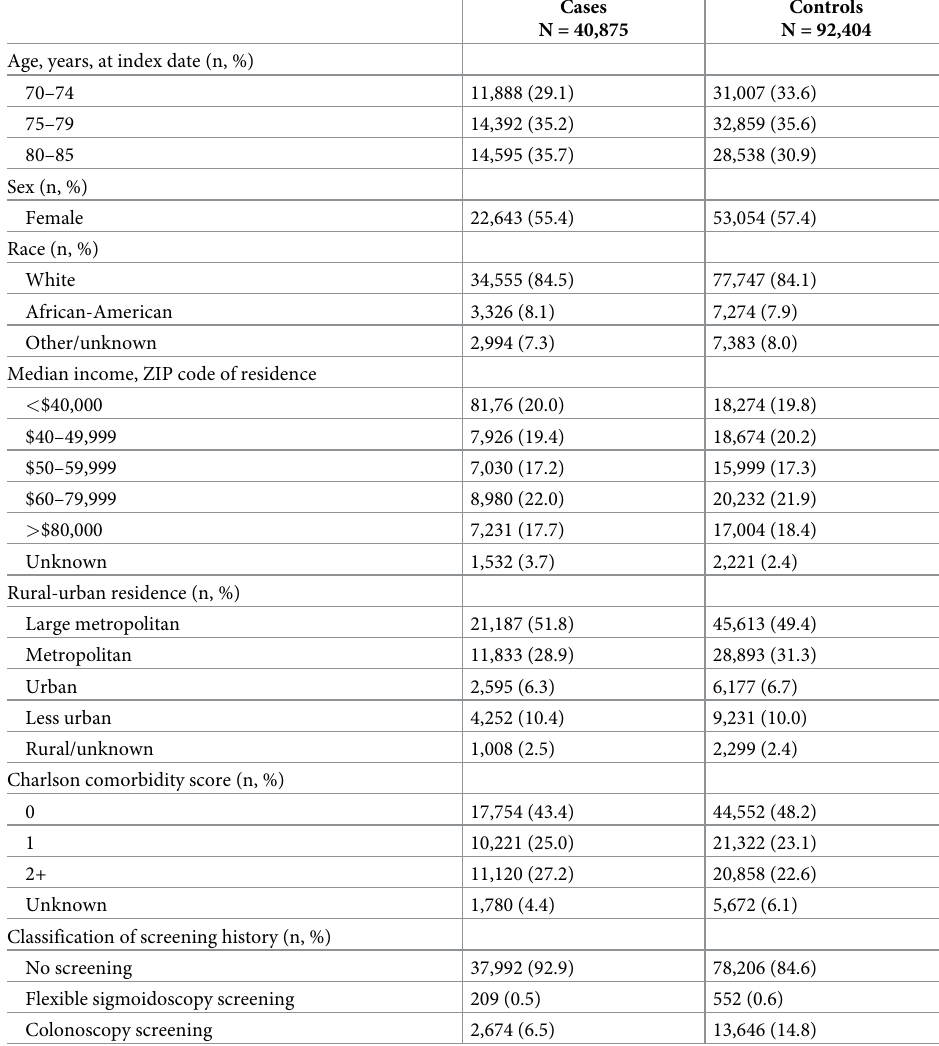
Table 1. Characteristics of colorectal cancer cases diagnosed during 2004–2013 and their matched controls, SEER-Medicare �